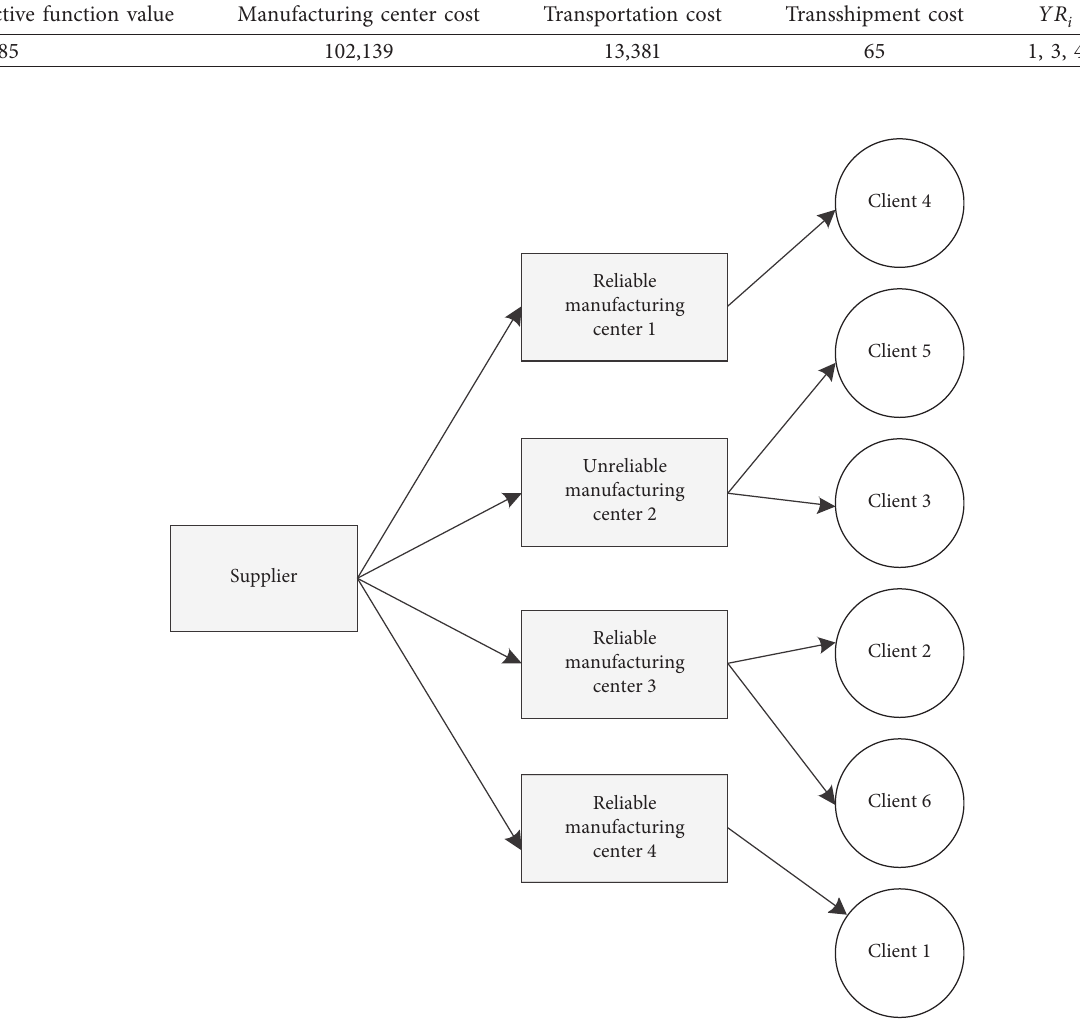
Figure 3: Intersite logistics transfer